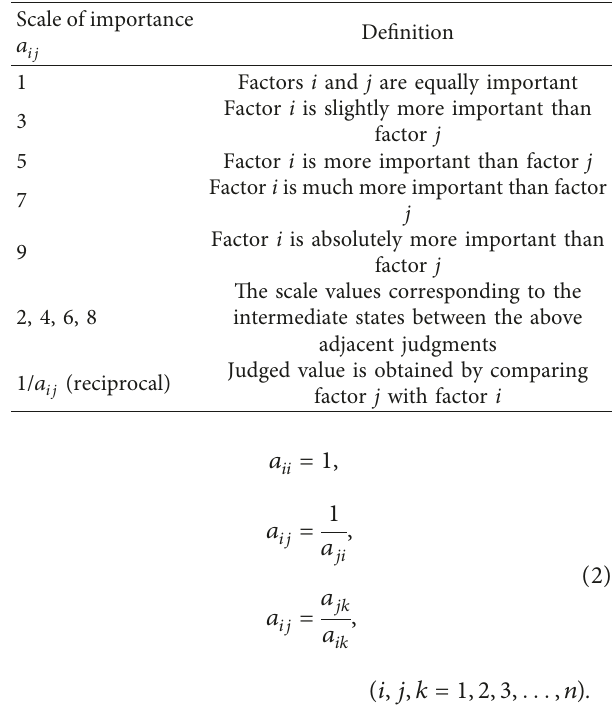
Table 2: 1 ∼ 9 scaling